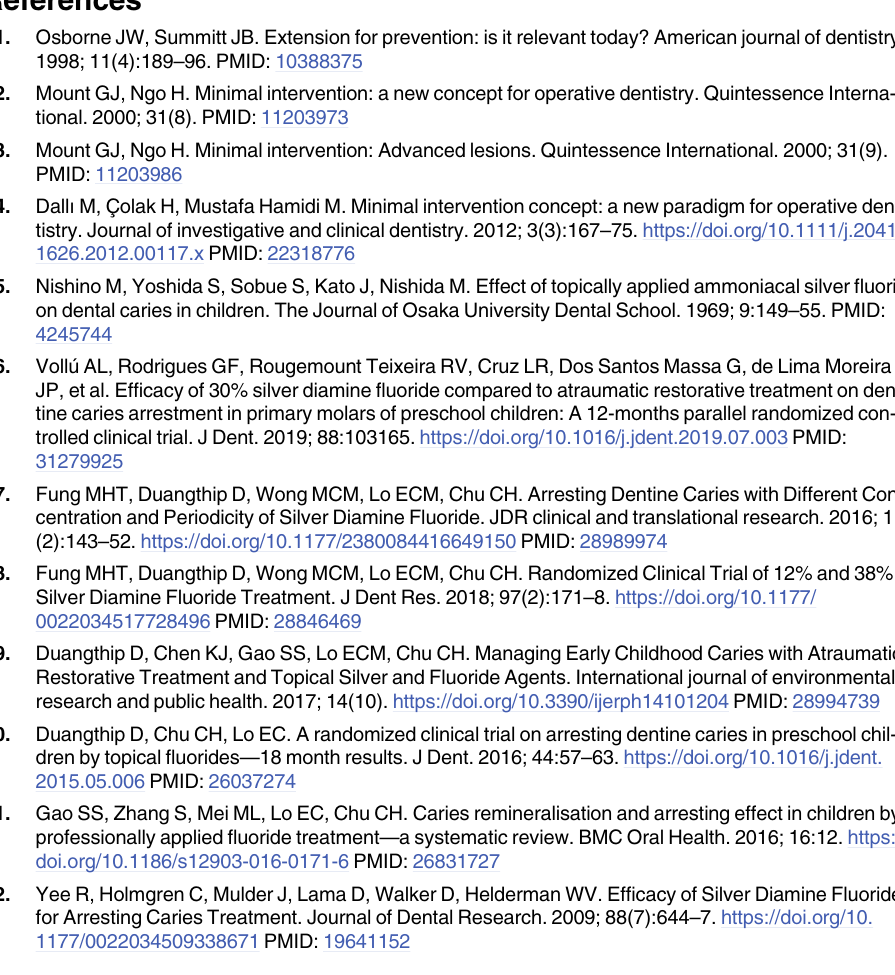
S1 Fig. PRISMA flow chart of the literature search and study